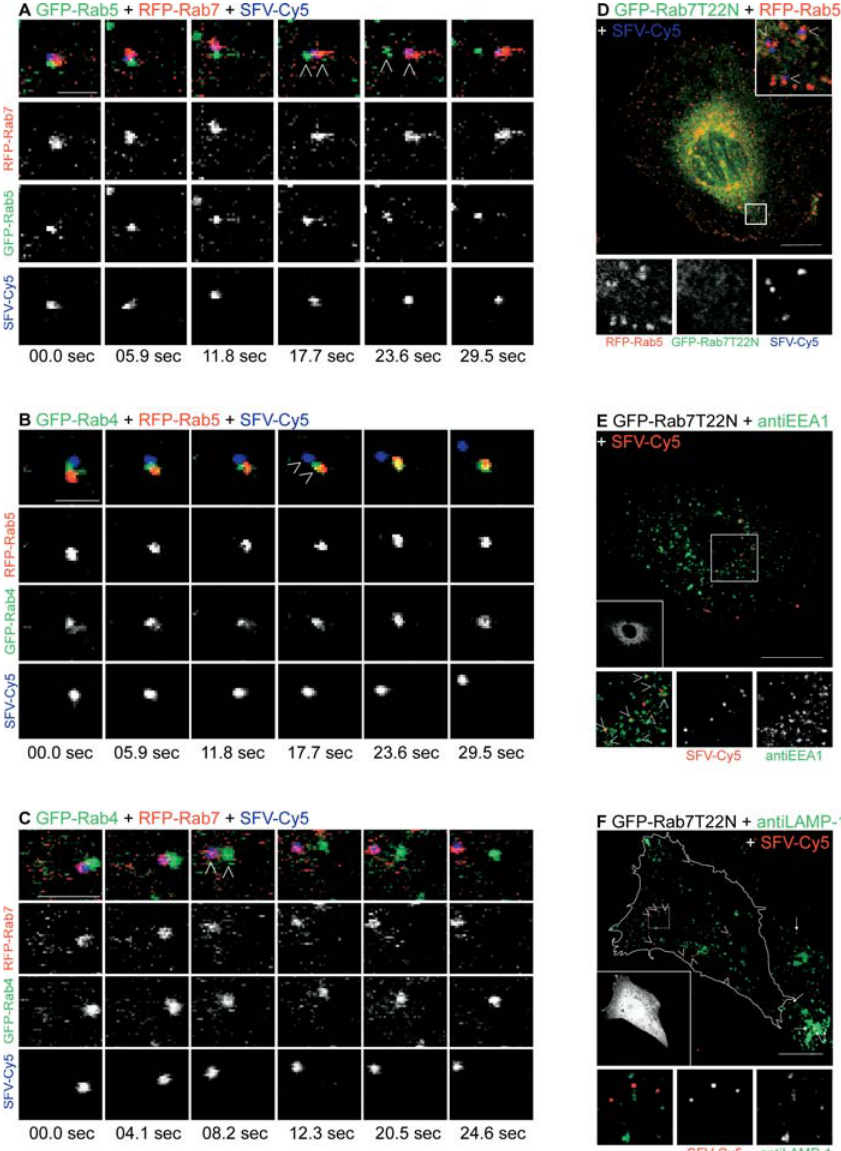
Figure 5. Sorting of Rab7 and SFV from Early Endosomes (A–C) Selected images obtained from a time series starting 20 min after warming. Vero cells were transfected with (A) GFP-Rab5 and RFP-Rab7, (B) GFP- Rab4 and RFP-Rab5, or (C) GFP-Rab4 and RFP-Rab7; SFV-Cy5 was then added. SFV-Cy5 is sorted away from Rab5- and Rab4-positive endosomes in a Rab7-positive vesicle (arrowheads). Scale bars represent 2.5 l m. (D) Confocal microscopy of a Vero cell transfected with the dominant negative GFP-Rab7T22N and RFP-Rab5, followed by incubation with SFV-Cy5. Virus was internalized for 1 h at 37 8 C. SFV-Cy5 is present in large Rab5-positive endosomes (arrowheads). Scale bar represents 10 l m. (E and F) Confocal microscopy of Vero cells transfected with the dominant negative GFP-Rab7T22N (insets), followed by incubation with SFV-Cy5. Virus was internalized for 1 h at 37 8 C. Cells were fixed, permeabilized, and immunostained for (E) EEA1 or (F) LAMP-1. In all, 86.3% of SFV-Cy5 (red) is present in large EEA1-positive endosomes (green in [E]) and not in LAMP-1-positive structures (green in [F]) (arrowheads). Note that SFV-Cy5 is present in LAMP- 1-positive structures in untransfected cells (arrows). Scale bars represent 10 l m. DOI: 10.1371/journal.pbio.0030233.g005